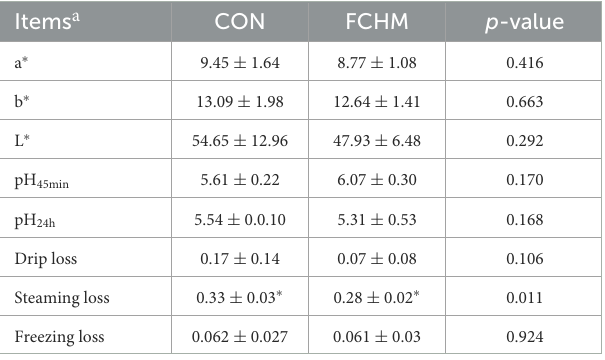
TABLE 5 Effects of FCHM on meat quality of broilers.